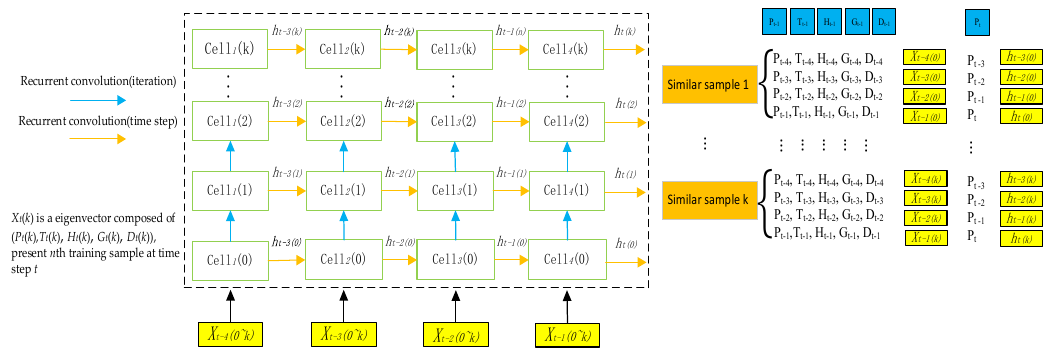
Figure 7. The training process of LSTM.